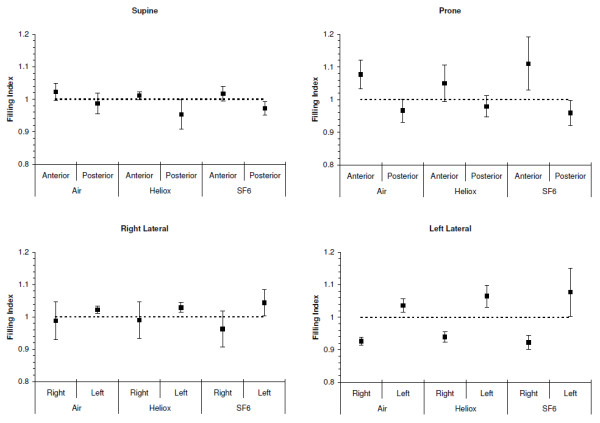
Filling indices for the three gas mixtures in each of four body positions. The FI for the anterior lung was significantly different to the posterior lung for supine and prone position (P < 0.001). Similarly the FI of the left lung was significantly different to the right lung in both the right and left lateral position (P < 0.001). The mean and 95% confidence interval are presented. The dotted line indicates an FI = 1, where the rate of impedance change in the ROI is similar to the global impedance change. # indicates significant differences (P < 0.001) between anterior and posterior, and between left and right respectively.